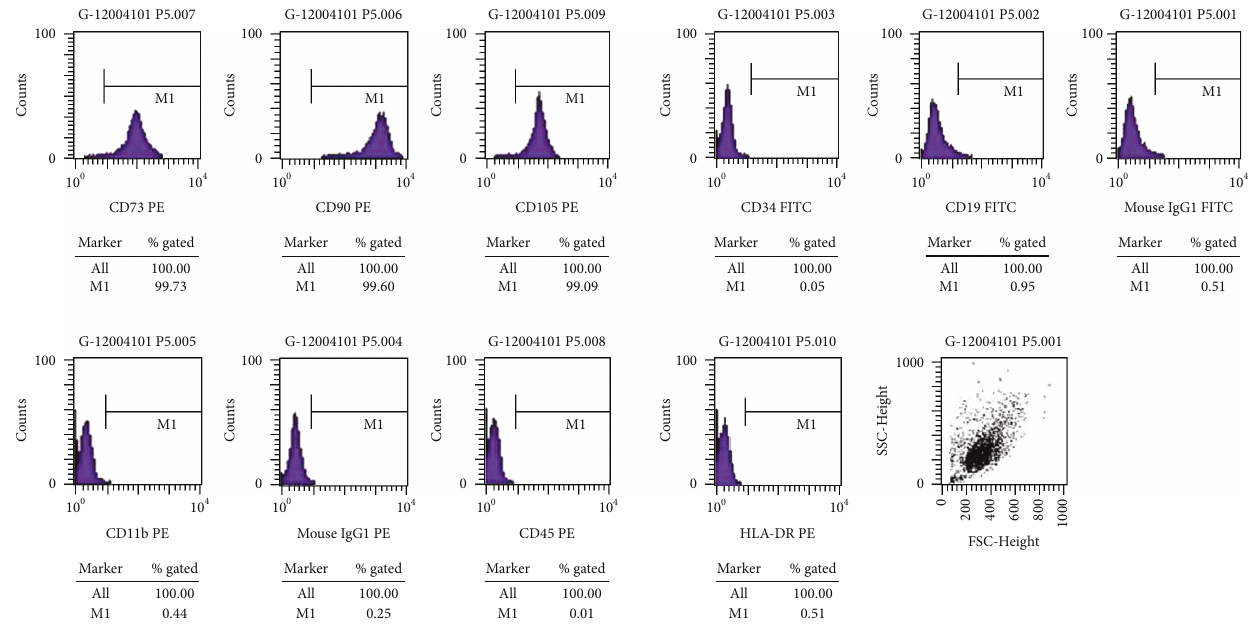
Figure 2: Cellular phenotype of hUMSCs detected by fl ow cytometry.